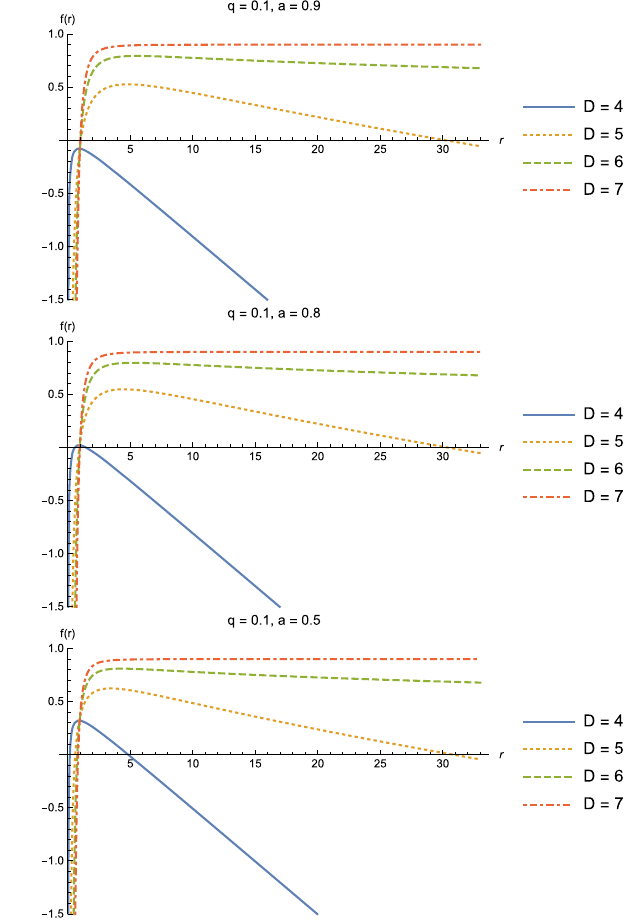
Fig. 1 The function f ( r ) in D-dimensional gravity for ω q = − 2 / 3, q = 0 . 1, M = 1 and for differents values of a and